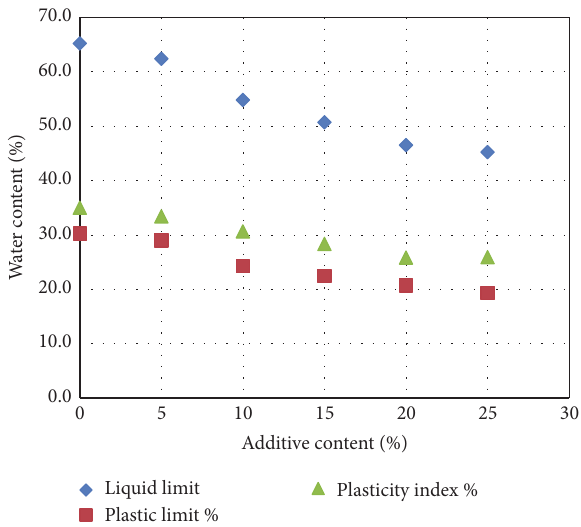
Figure 3: Variation of Atterberg limits with FSSA contents.